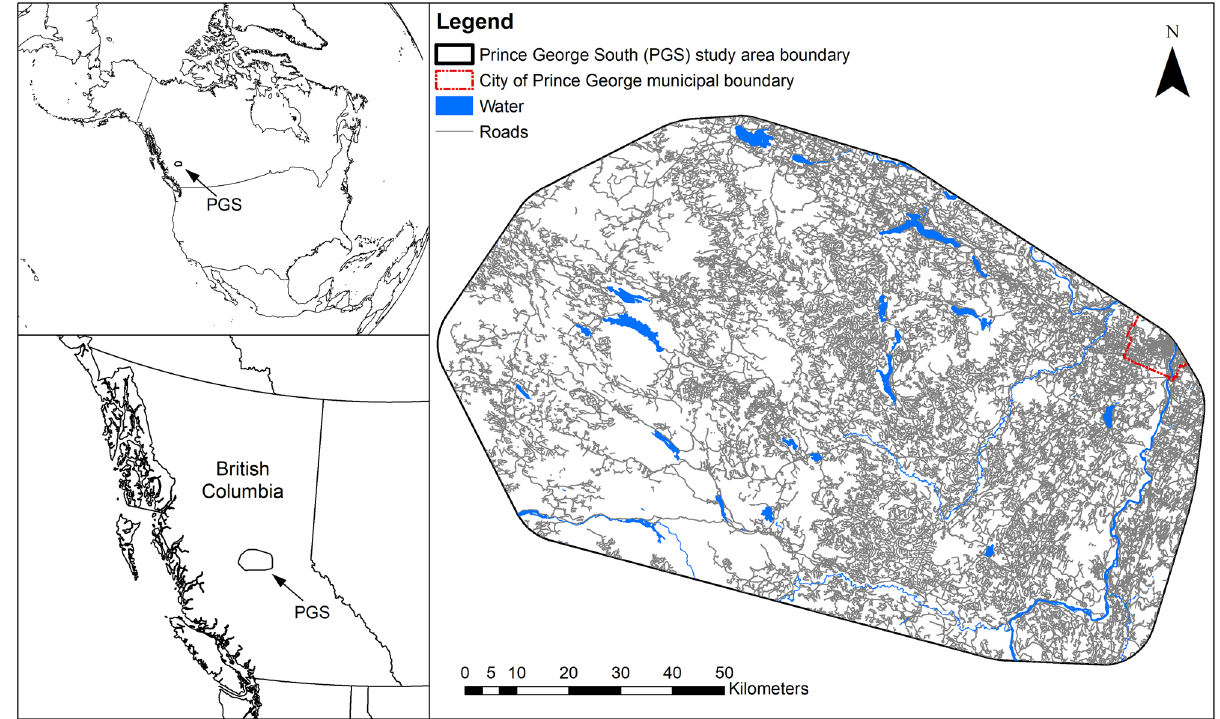
Figure 1. The Prince George South (PGS) study area, located in interior British Columbia, Canada. PGS is heavily altered with linear features (in grey) and cleared forest. The municipal boundary for the city of Prince George is outlined in red. Waterbodies are shown in blue. The map was created in ArcGIS v.10 (www. esri. com).